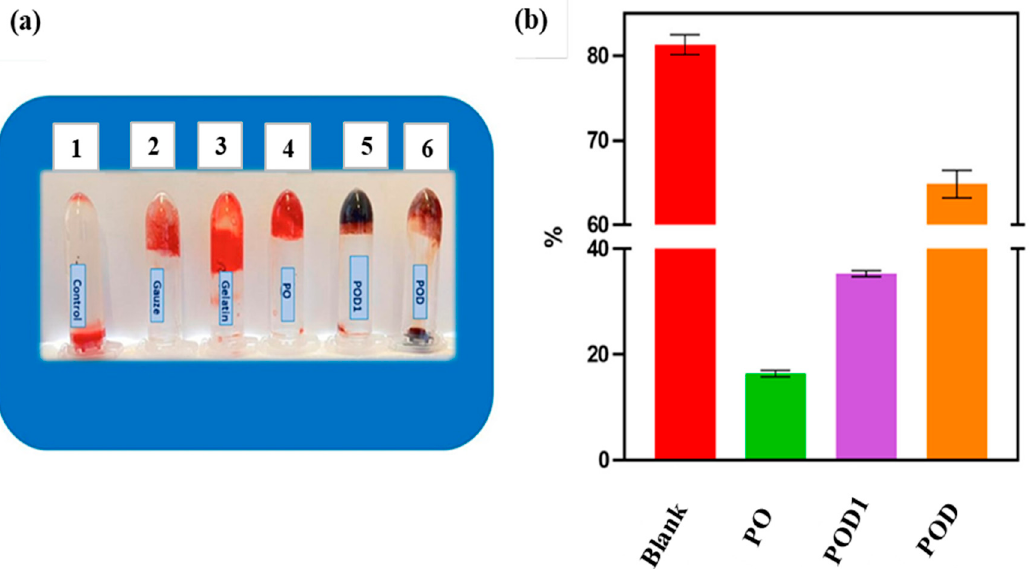
Figure 10. Results of in vitro blood coagulation: ( a ) Photographs of blood clotting. 1: control; 2: medical gauze; 3: gelatin; 4: PO (oxidized pullulan); 5: POD (oxidized pullulan/dopamine cryogel prepared by in situ loading of dopamine; 6: POD1 (oxidized pullulan/dopamine cryogel sample prepared by post-incorporation of dopamine); ( b ) Blood clotting index of the cryogel samples incubated in whole blood for 10 min. Reproduced from [93] with permission from MDPI,